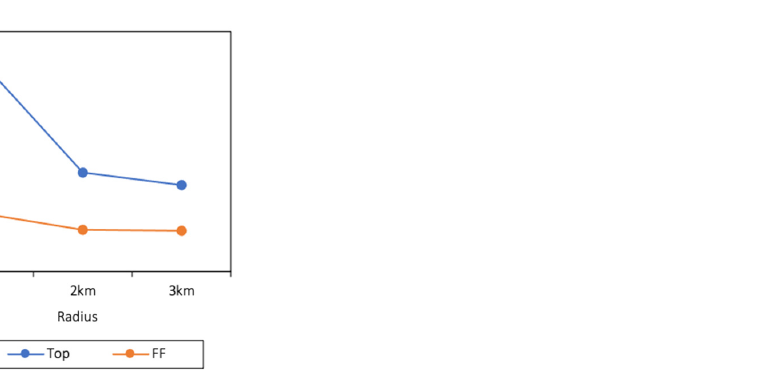
Figure 2. Estimated coefficients of the number of Tops and FFs within 1, 2, 3 km by 2SLS. As described in the previous section, there were potential endogeneity problems. The comparison between the results of OLS and 2SLS confirmed this hypothesis. Employing ically addressed endogeneity problems. Using 2SLS to estimate the coefficients of all mod- consistent estimates. The results of the first stage are shown in Table 4. We tested the en- dogeneity of the instrument using the Durbin–Wu–Hausman test (DWH). The third row